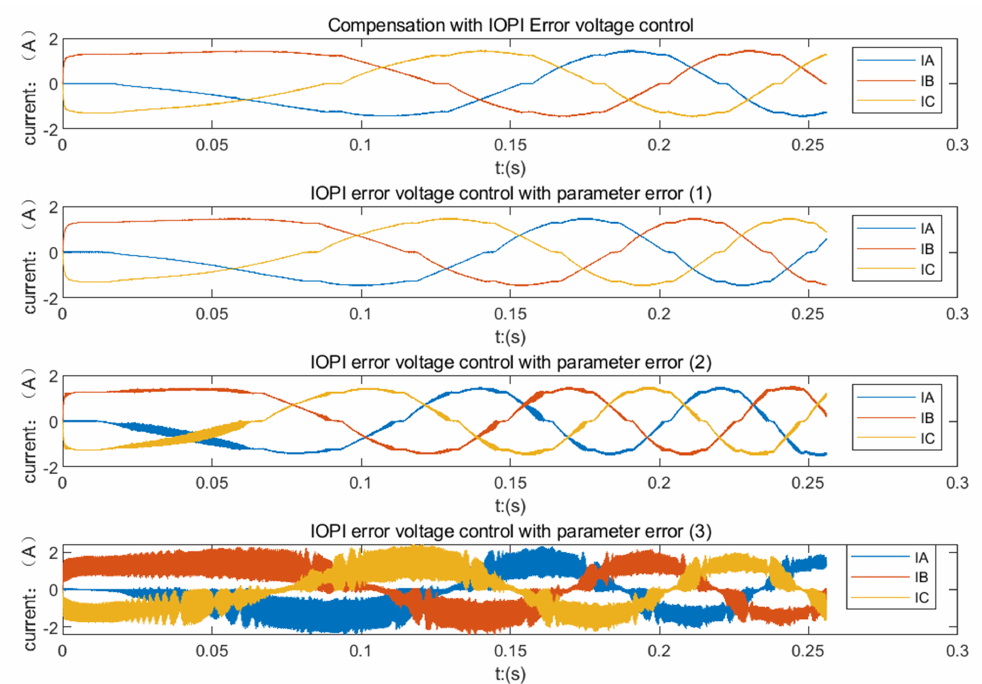
Figure 22. The three-phase current response of the optimal IOPI error voltage control in the error motor parameters.